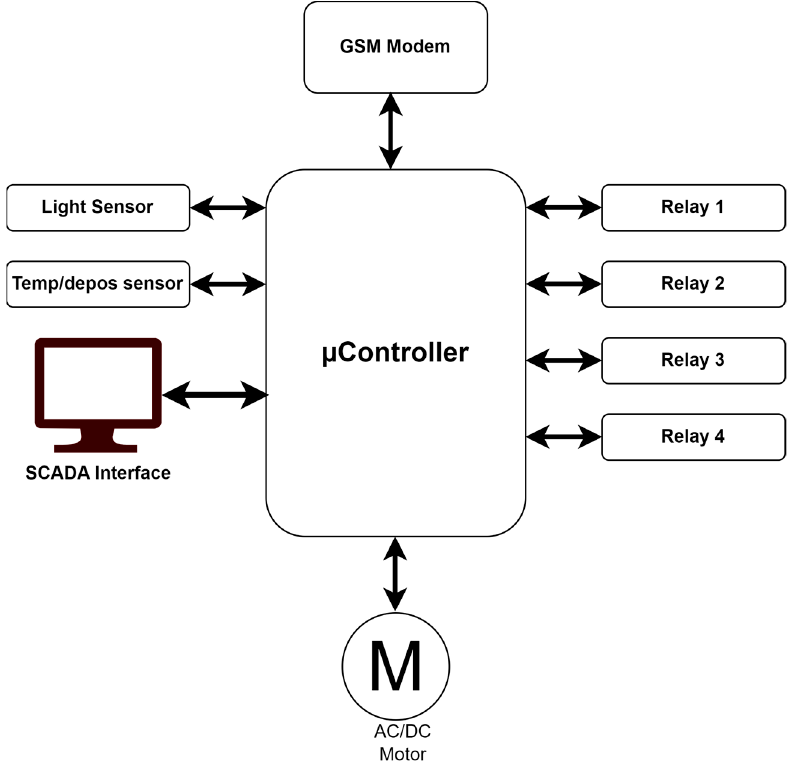
Figure 9. Diagram of a remote terminal unit.